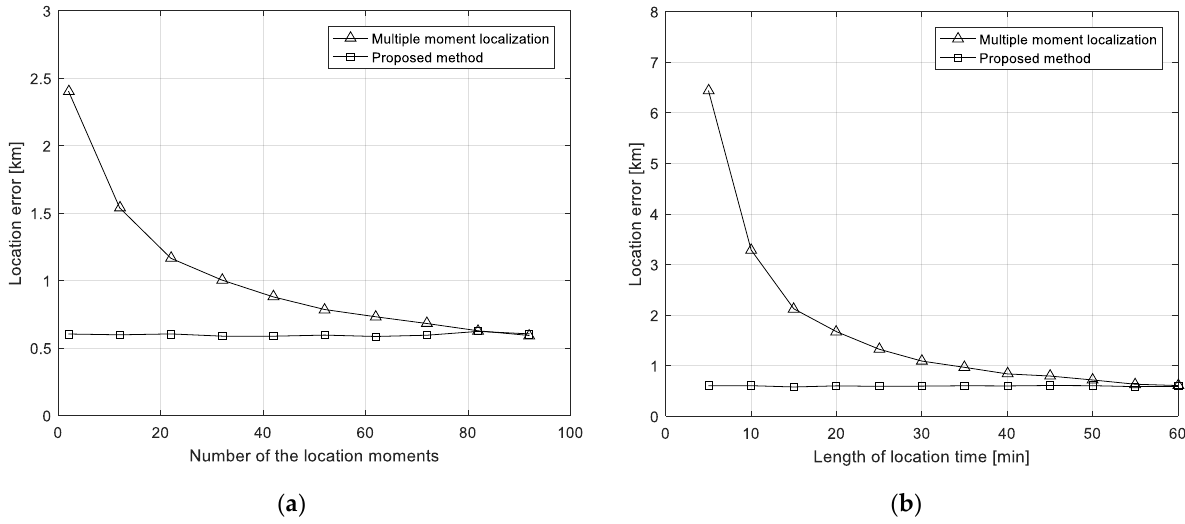
Figure 4. Experiments on the influence factors of location error. ( a ) location errors versus the number of the location moments; ( b ) location error versus the length of location time.